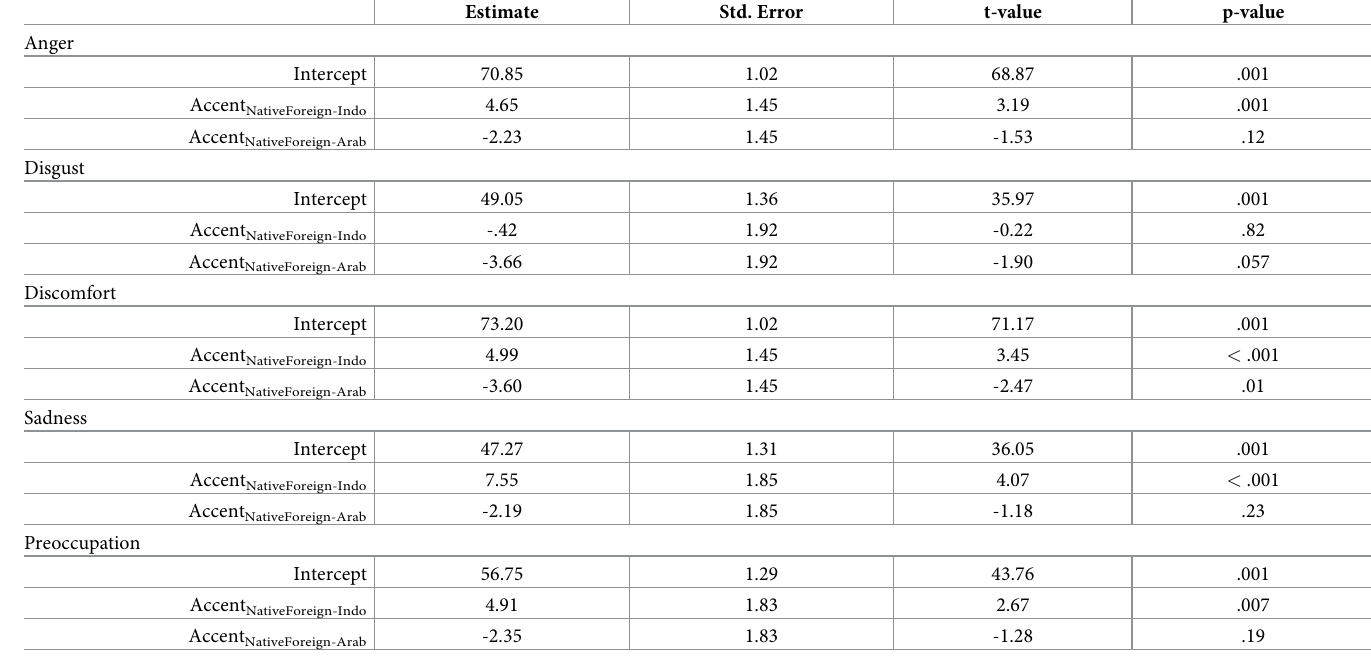
Table 8. Estimates, standard error, t-values, and p-values of the predictor Accent (Accent NativeForeign-Indo and Accent NativeForeign-Arab ) on the five emotions (anger, disgust, discomfort, sadness, and preoccupation). Estimate Std. Error